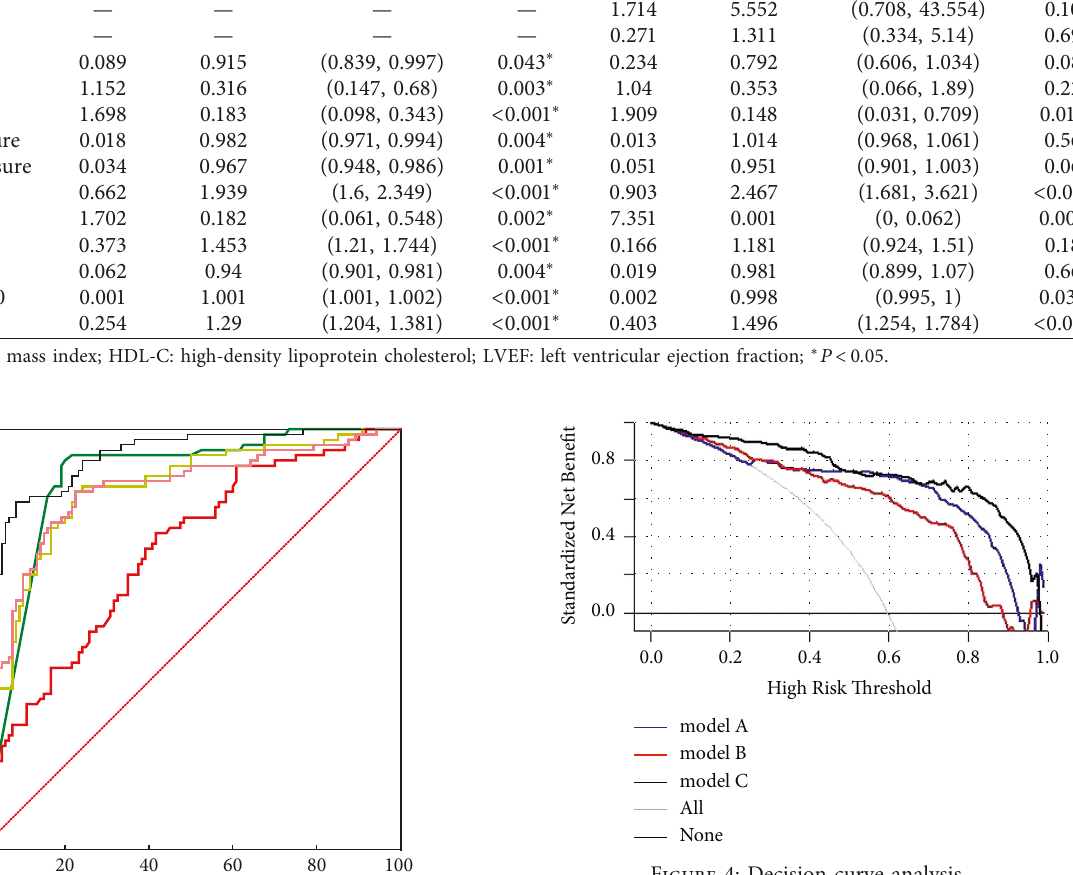
Figure 4: Decision curve